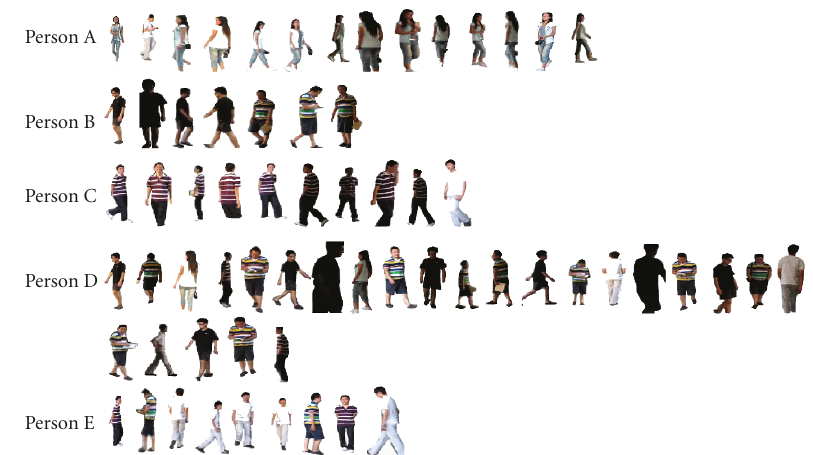
Figure 19: Trajectories recovered by EM with backward appr.I inference initialized by K-means clustering.